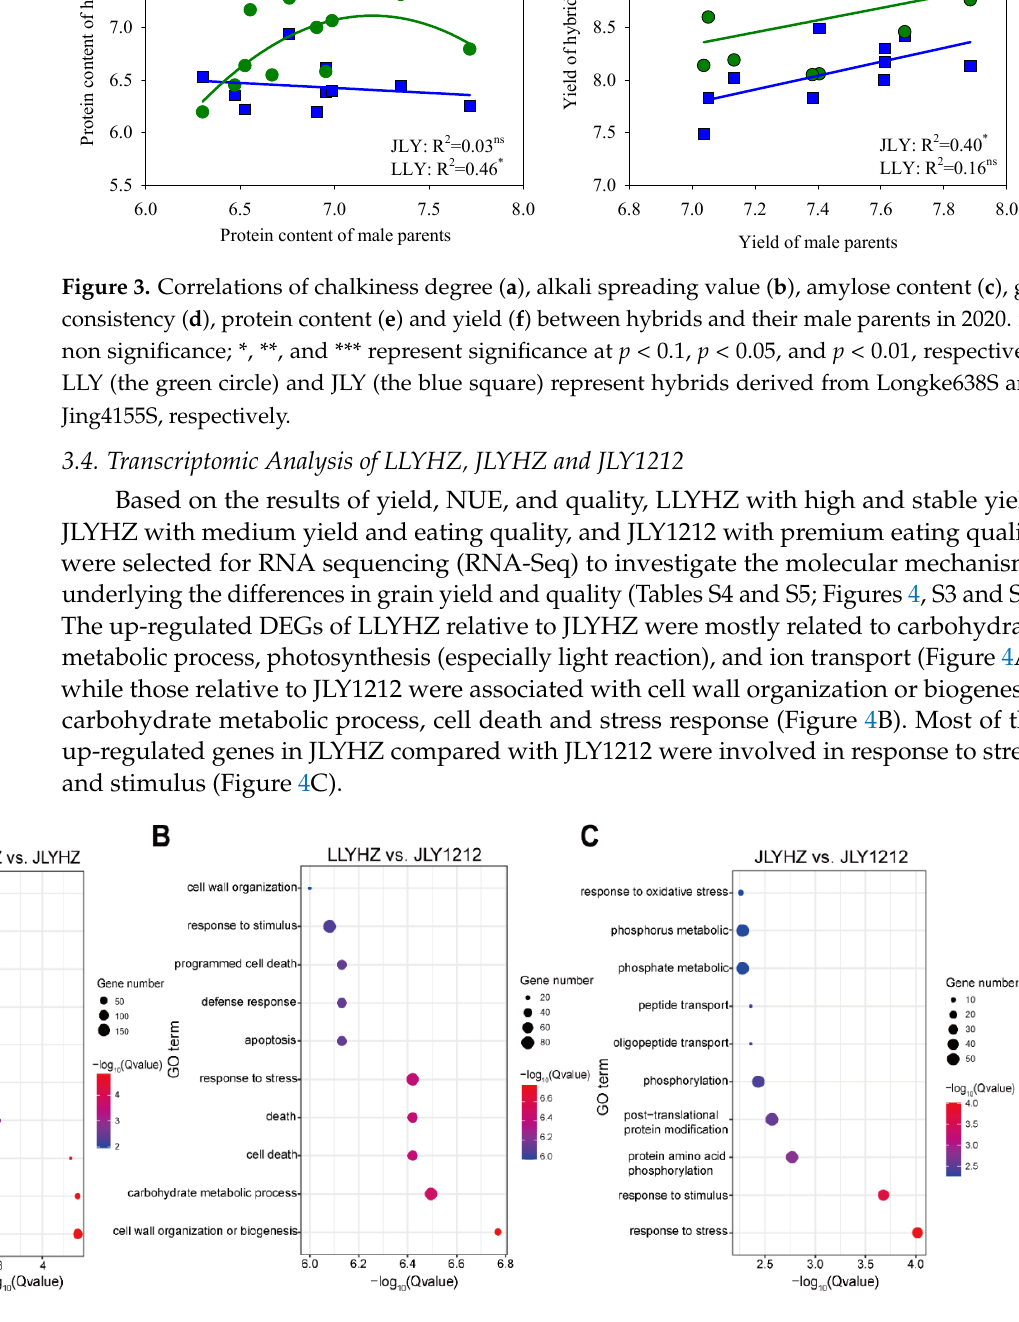
Table 5. The overlapping genes differentially expressed of LLYHZ compared with JLYHZ, and LLYHZ compared with JLY1212 in spikelets at flowering stage. Locus